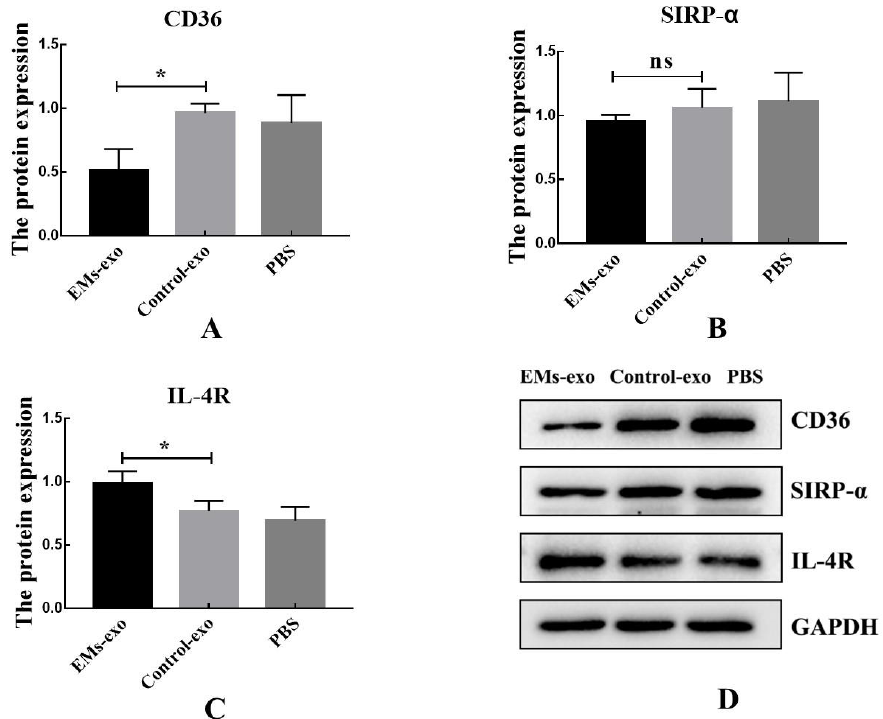
Figure 3. Exosomes influence the expression of macrophage receptors. ( A ) The protein expression of macrophage receptors CD36. ( B ) The protein expression of macrophage receptors SIRP- α . ( C ) The protein expression of macrophage receptors IL-4R. ( D ) Western blot was used to detect the protein expression of macrophage receptors after the intervention of exosomes from the EMs group, exosomes from the control group, and PBS. Data are expressed as the mean ± SEM (* p < 0.05). ns: not